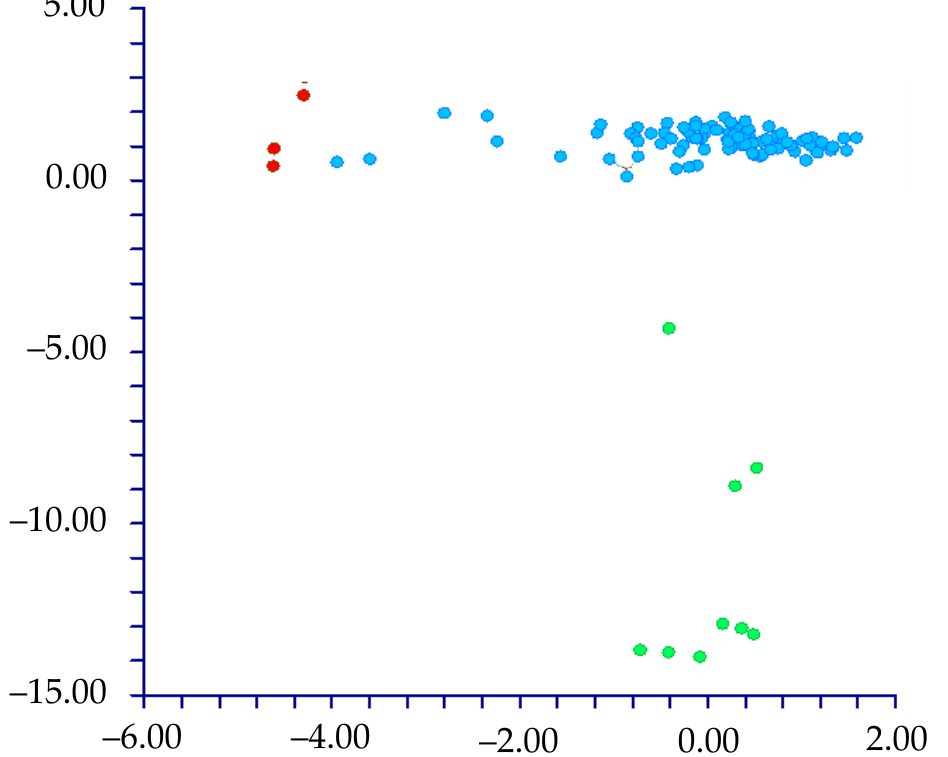
Figure 8. DA graph: [first (axis x ) vs. second (axis y ) component] performed on groups derived from PCA: red dots: crassipes group; green dots: muricatus / viridis group; blue dots: residual group.